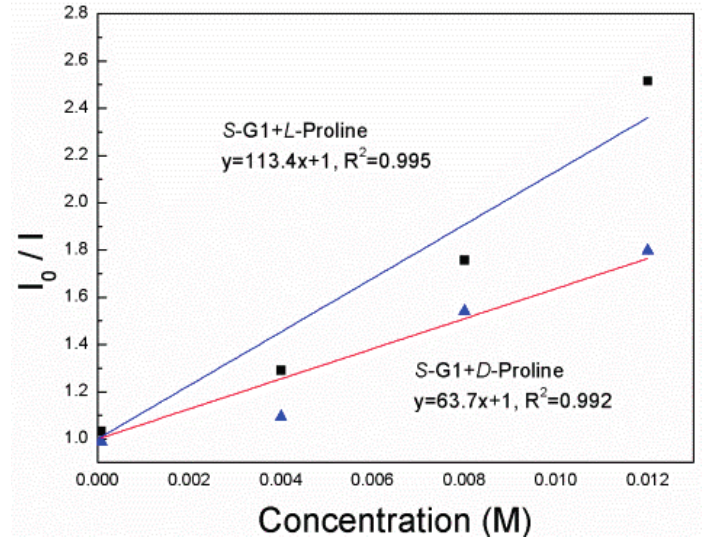
Figure 5. Stern–Völmer plot of S -G1 (8 × 10 − 5 mol·L − 1 ) in EtOH in the presence of D -proline and L -proline ( λ ex = 330